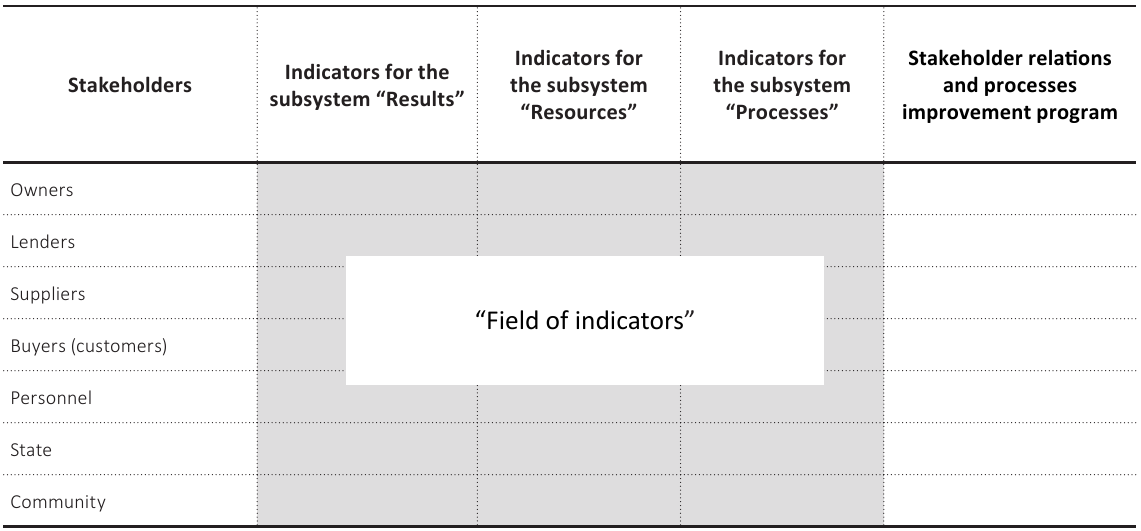
Figure 3. Matrix of SRPR